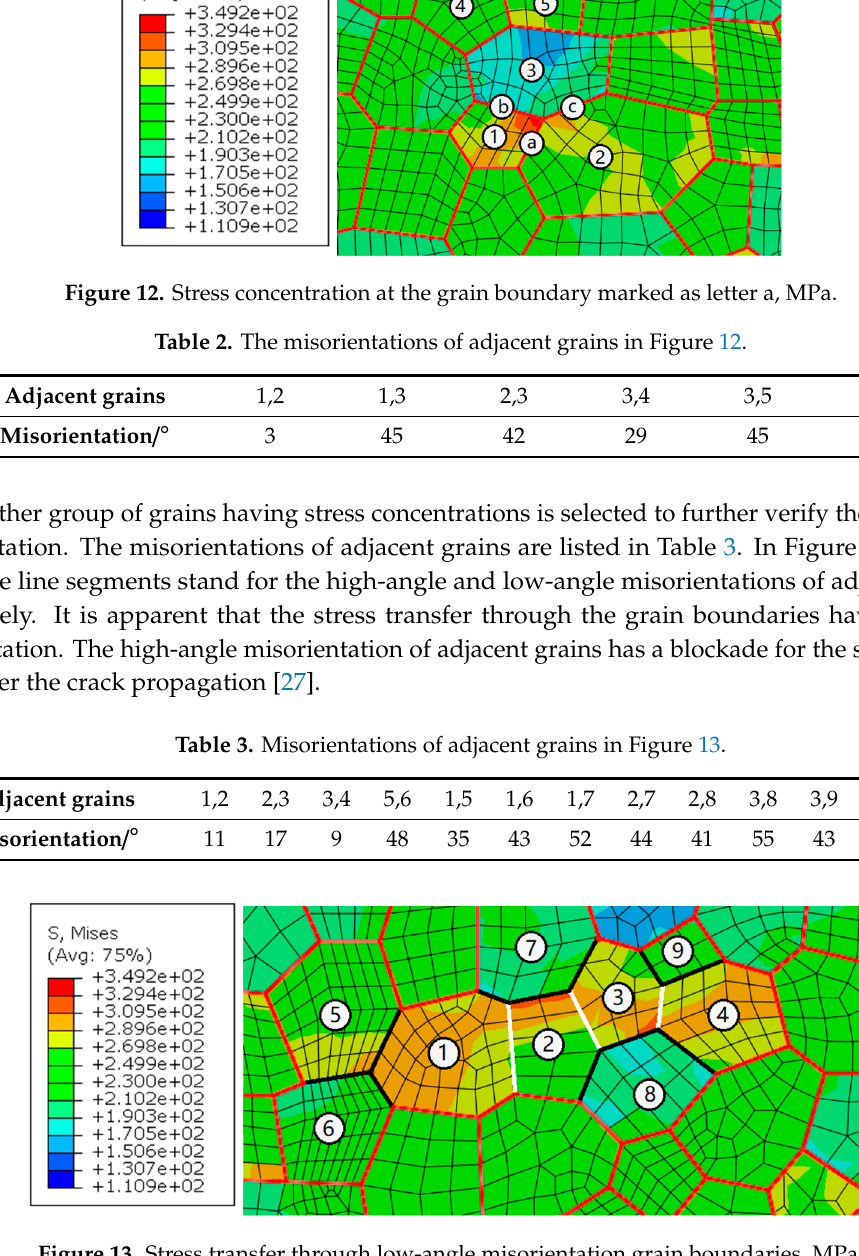
Table 2. The misorientations of adjacent grains in Figure 12.